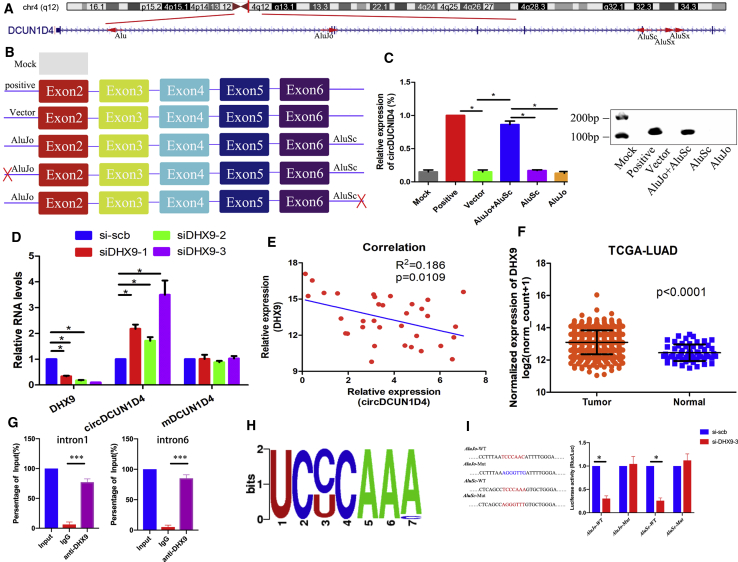
The expression of circDCUN1D4 in LUAD can be regulated by DHX9(A) The location of DCUN1D4 in the genome and RepeatMasker analysis of the intron sequences of DCUN1D4. (B) A schematic drawing of six types of circDCUN1D4-overexpressing vectors. (C) qRT-PCR assay detected the expression of circDCUN1D4 after transfection with the six types of circDCUN1D4-overexpressing vectors (mean ± SD, n = 4). (D) qRT-PCR detection of circDCUN1D4 and mDCUN1D4 after DHX9 knockdown using RNAi in H1299 cells (mean ± SD, n = 4). (E) The correlation between the relative expression of DHX9 and circDCUN1D4 in 34 LUAD tissues. (F) The relative mRNA levels of DHX9 in LUAD in TCGA database. (G) The RIP assay results demonstrated that the DHX9 interacts with the AluJo/AluSc region (mean ± SD, n = 4). (H) The motif of DHX9. (I) The luciferase report assay results demonstrated that the DHX9 interacts with the Alu region of circDCUN1D4-intron1/intron6 (mean ± SD, n = 4).